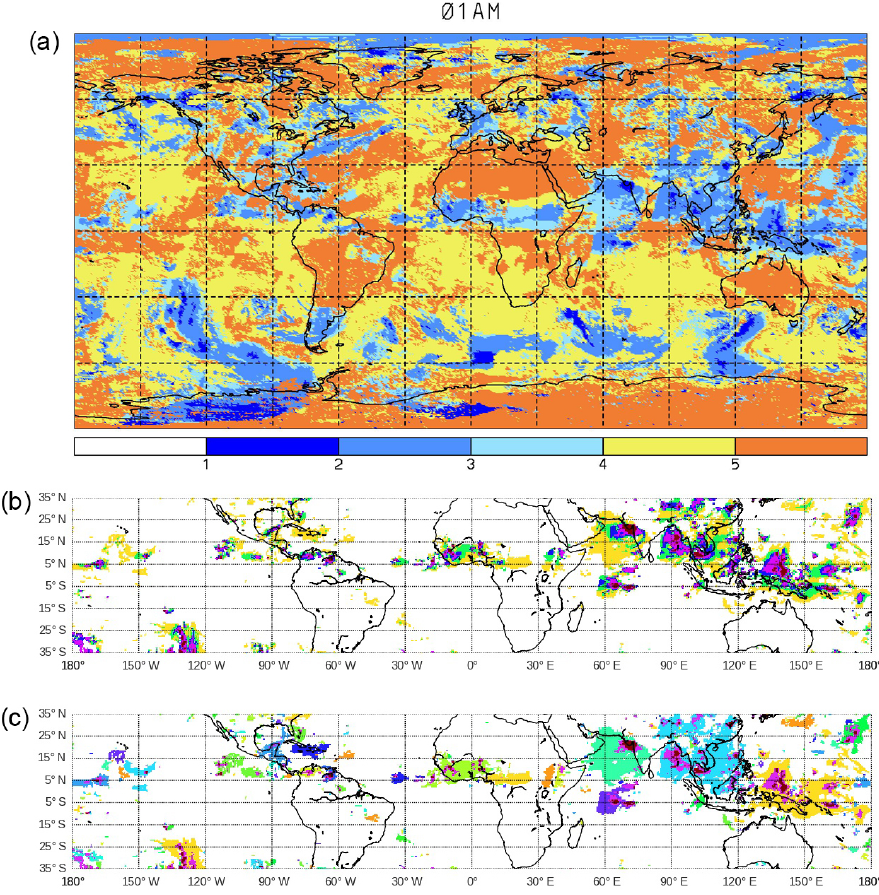
Figure 4. Geographic map of AIRS cloud data for 1 July 2007 at 01:30LT. (a) Cloud types are identified as follows: blue indicates upper tropospheric clouds (deeper blue indicates more opaque high clouds); yellow indicates mid-level and low clouds; and orange indicates clear sky. (b) UT clouds for five emissivity classes (0.1, 0.6, 0.8, 0.92, 0.98 and 1) are represented, respectively, by yellow, green, blue, magenta and red. (c) UT cloud systems are represented with different colors indicating different systems; opaque and convective areas are marked with magenta and deep red, respectively.